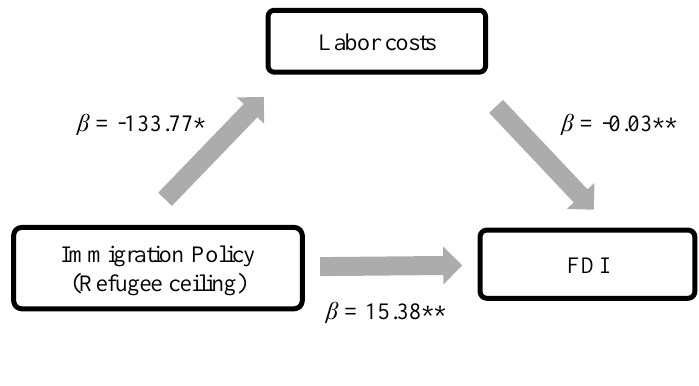
Figure A2 . Restrictive Immigration